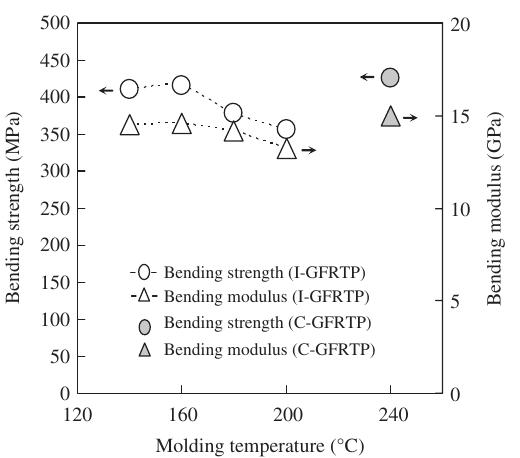
Figure 12 Results of the three-point bending tests for I-GFRTP and C-GFRTP.